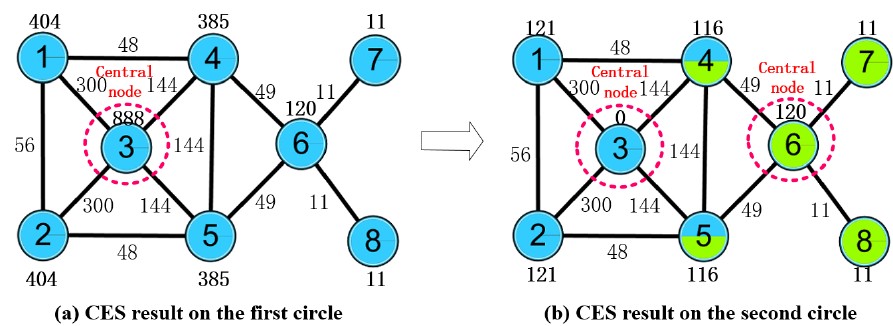
Figure 3. An example of a CES result.